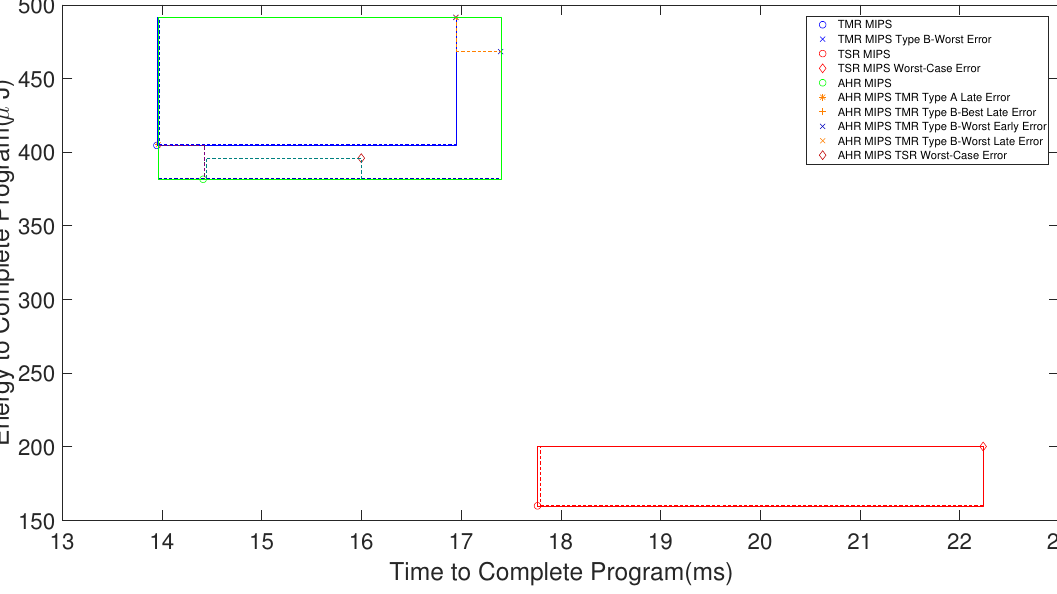
Figure 12. Average performance bounds for AHR MIPS with a TMR to TSR point at 50,000